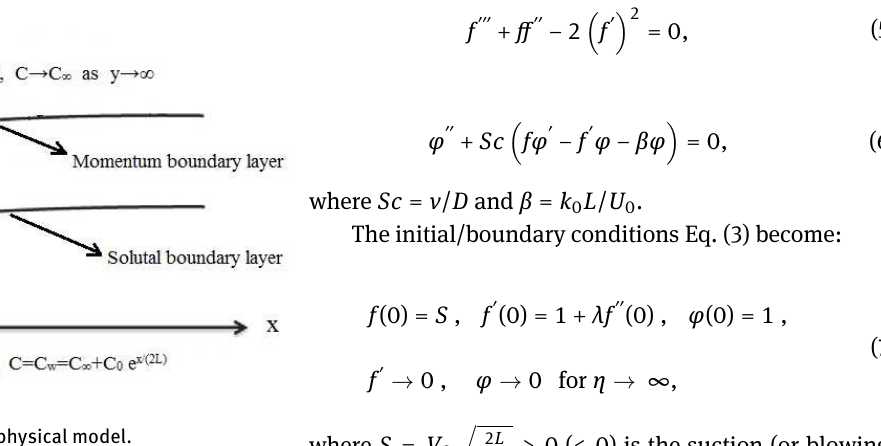
Figure 1: Schematic diagram of the physical